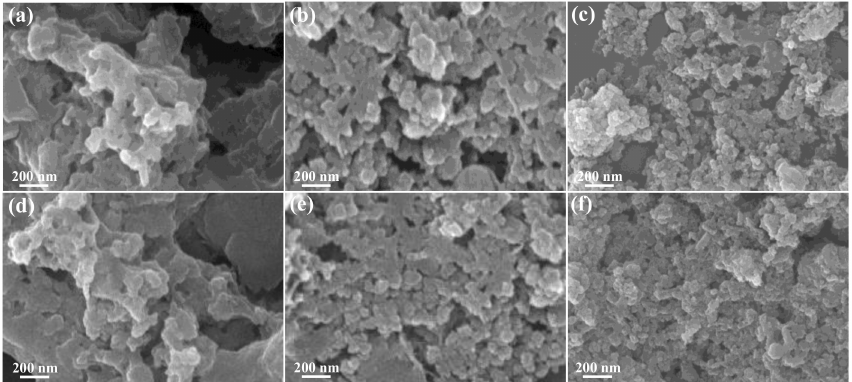
Figure 6. SEM images of ( a ) NiS 2 , ( b ) NiS 2 / CNTs and ( c ) NST / CNTs@C after 20 cycles; SEM images of ( d ) NiS 2 , ( e ) NiS 2 / CNTs and ( f ) NST / CNTs@C after 1000 cycles.